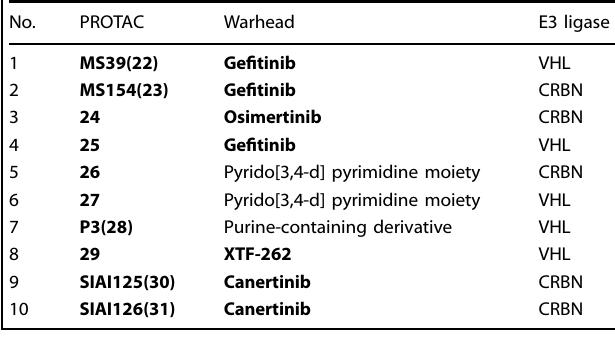
Table 2. The summary and comparison of PROTACs targeting EGFR